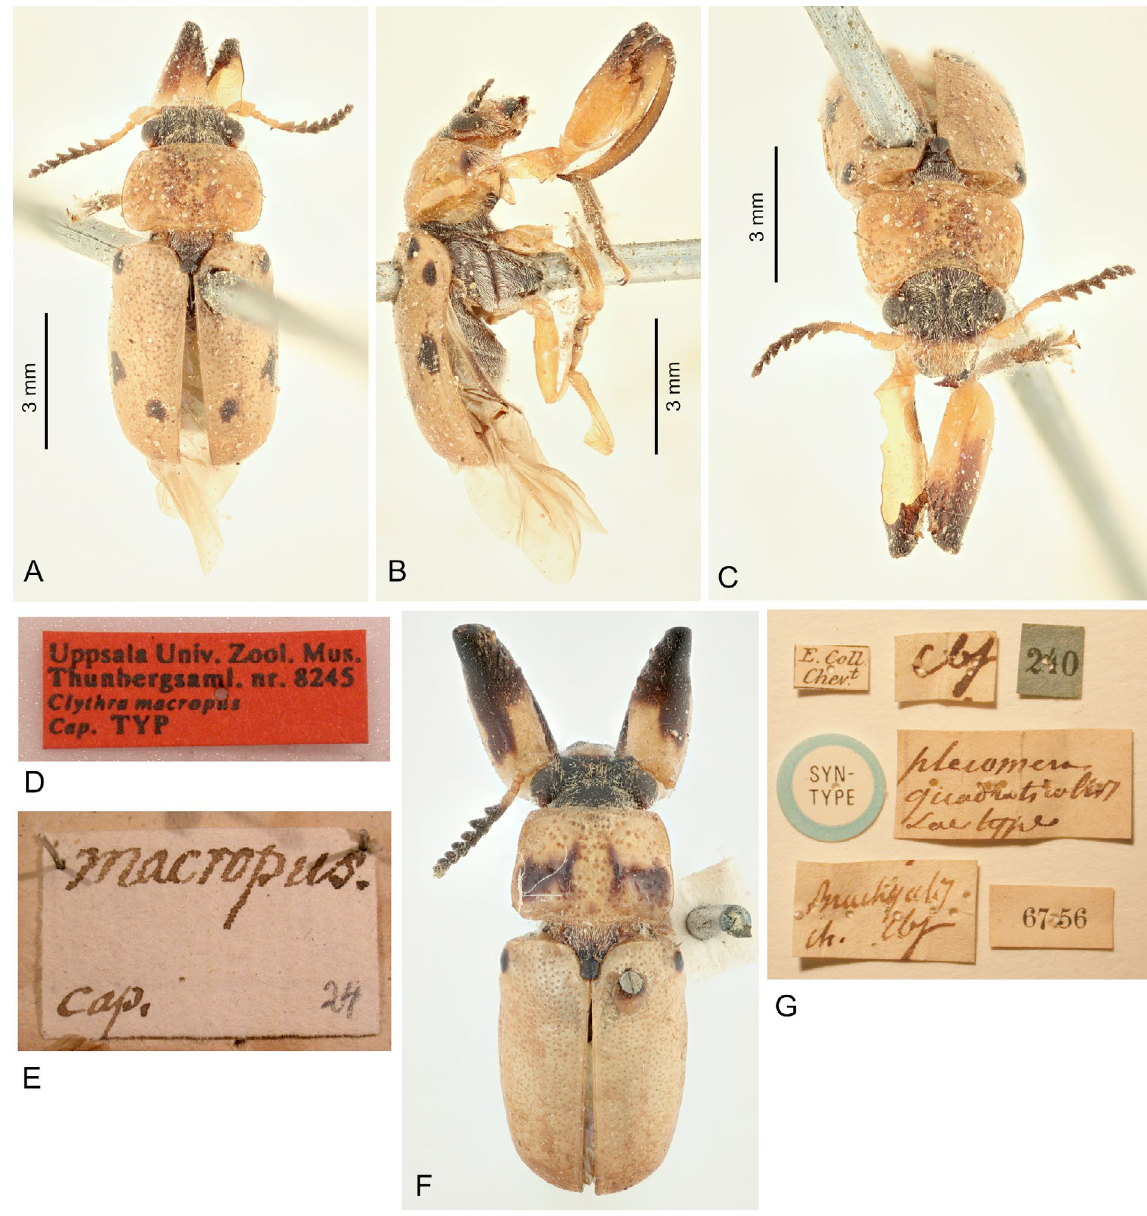
Fig. 9. Plecomera thunbergii thunbergii (Lacordaire, 1848). A–E . Syntype of Clythra macropus Thunberg, 1821, ♂, 7.5 mm, UUZM. A . Dorsal view. B . Lateral view. C . Frontal view. D . Label. E . Box label. F–G . Syntype of Clythra quadraticollis Lacordaire, 1848, ♂, not measured, BMNH. F . Dorsal view. G .